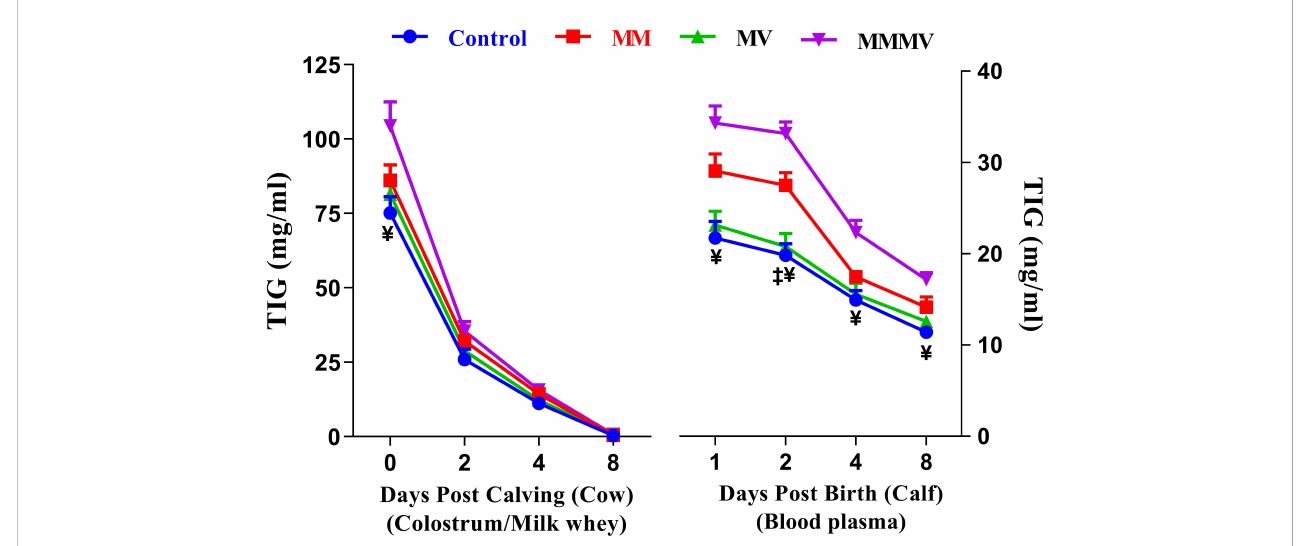
FIGURE 10 Total immunoglobulins (TIG) concentration (mg/ml) in colostrum/whey of different groups of Karan-Fries cows and TIG concentration (mg/ml) in the blood plasma of the calves born to different groups of Karan-Fries cows. Control: received basal diet only, MM: basal diet + injectable multimineral, MV: basal diet + injectable multivitamins, MMMV: basal diet + combination of injectable multimineral and multivitamins. The mean values with different superscript symbols represent signi fi cant differences with the control group at different days of peripartum in cows and post birth in calves; ‡ Control Vs MM, and ¥ Control Vs MMMV.